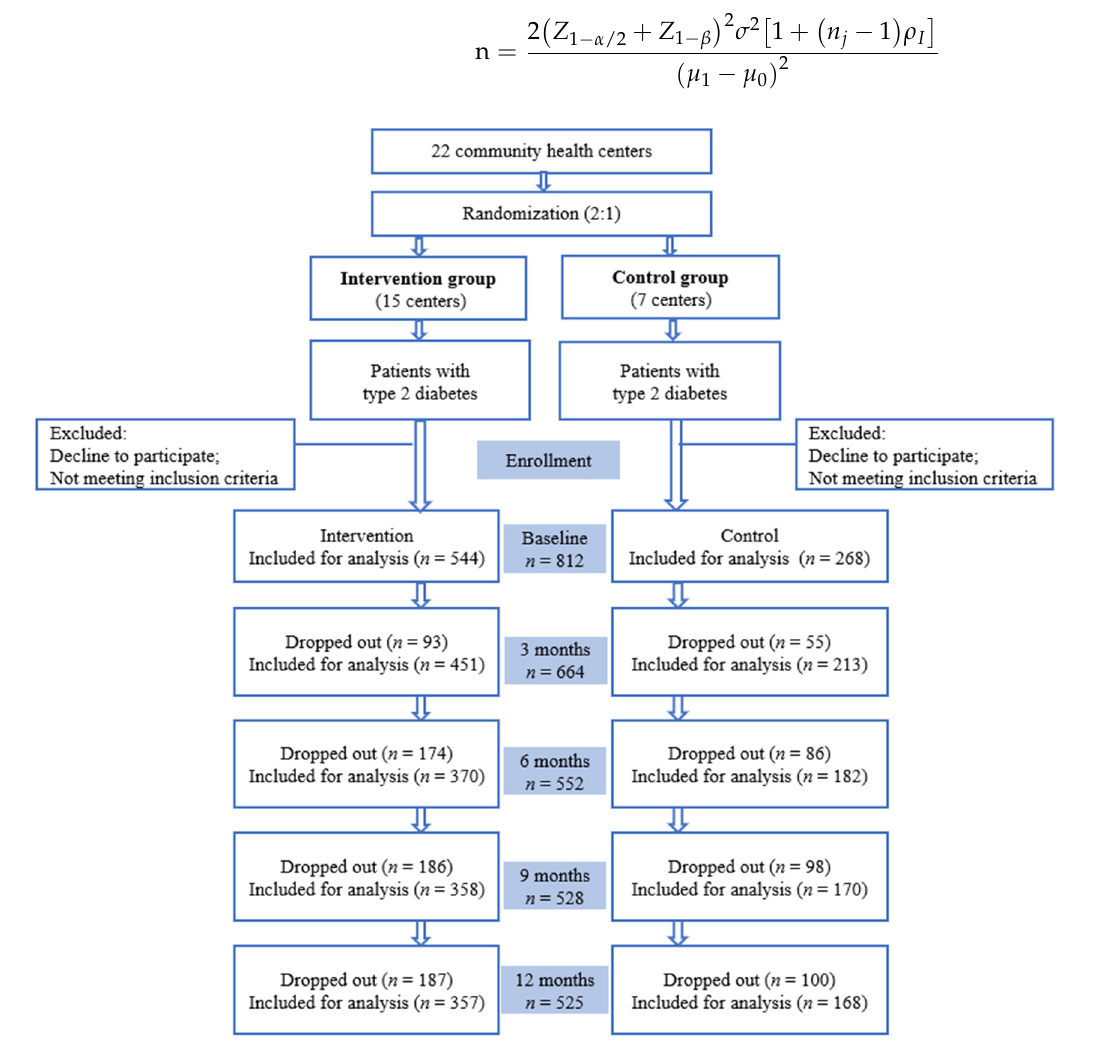
Figure 1. Trial profile.